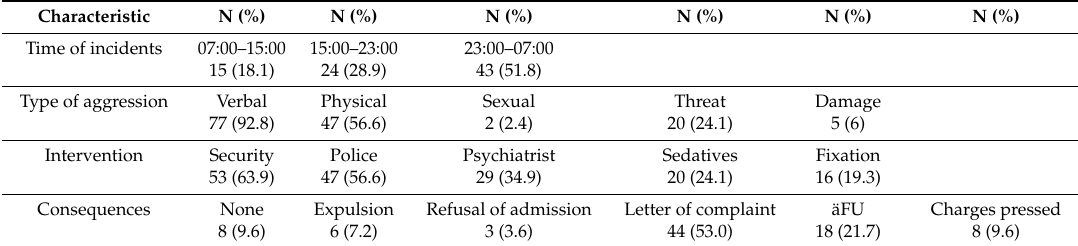
Table 2. Case characteristics of